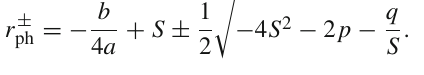
Fig. 2 The shadow of non-extremal Kerr black hole with m = 1 and a = 29 / 30, viewed from the equatorial plane ( θ 0 = π/ 2). Note the similaritybetweenthisandthemiddleplotofFig.1whichistheshadow of the extremal black hole but viewed from angle θ 0 = π/